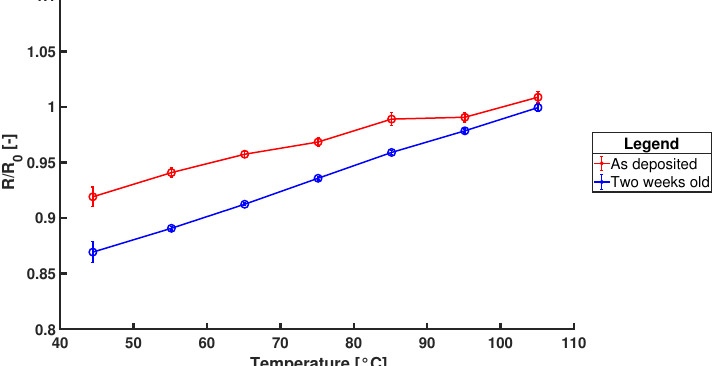
Figure A3. The effect of two weeks aging in ambient conditions on a 100nm Au layer. The TCR of the as deposited layer is 0.00161K − 1 and the TCR of the two week old layer is 0.00224K − 1